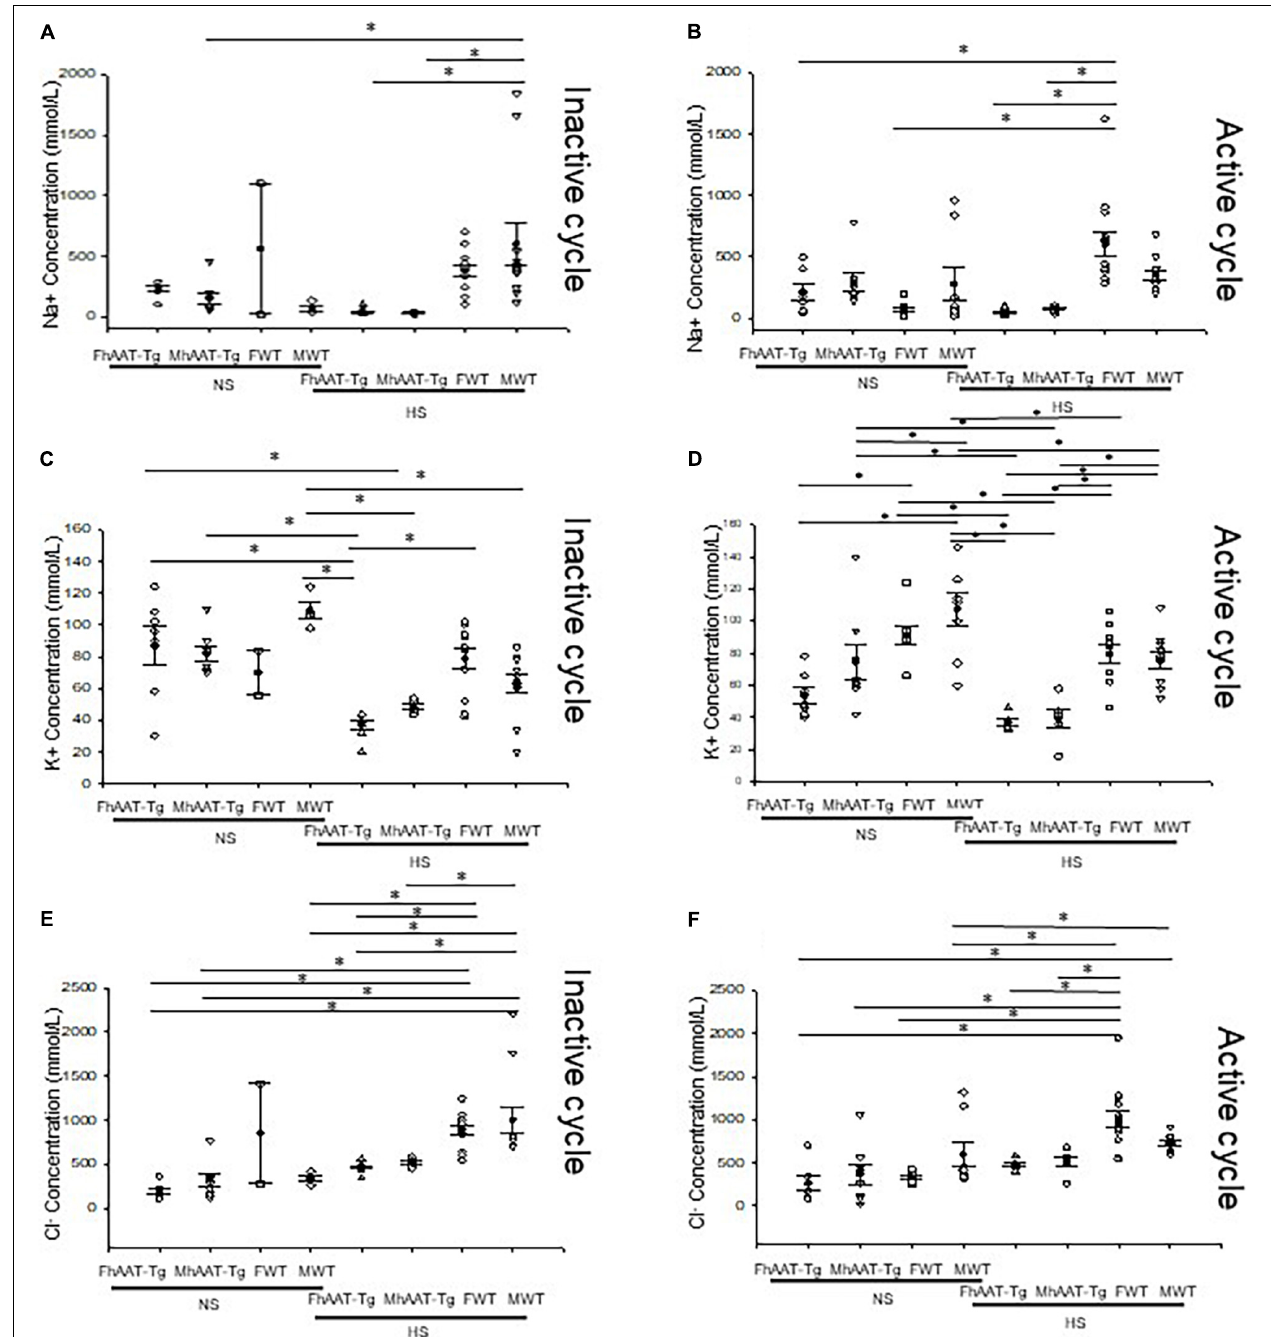
FIGURE 1 | Urinary electrolytes corresponding to the inactive and active cycles of male and female hAAT-Tg and C57B/6 wild-type mice maintained on a normal or high salt diet. (A) Urinary sodium concentrations during the inactive cycle for female and male hAAT-Tg mice and C57B/6 wild-type mice maintained on a normal salt (NS) or high salt (HS) diet. (B) Urinary sodium concentrations during the active cycle for female and male hAAT-Tg mice and C57B/6 wild-type mice maintained on a normal salt (NS) or high salt (HS) diet. (C) Urinary potassium concentrations during the inactive cycle for female and male hAAT-Tg mice and C57B/6 wild-type mice maintained on a normal salt (NS) or high salt (HS) diet. (D) Urinary potassium concentrations during the active cycle for female and male hAAT-Tg mice and C57B/6 wild-type mice maintained on a normal salt (NS) or high salt (HS) diet. (E) Urinary chloride concentrations during the inactive cycle for female and male hAAT-Tg mice and C57B/6 wild-type mice maintained on a normal salt (NS) or high salt (HS) diet. (F) Urinary chloride concentrations during the active cycle for female and male hAAT-Tg mice and C57B/6 wild-type mice maintained on a normal salt (NS) or high salt (HS) diet. N = 7 hAAT-Tg (4 female and 3 male) and N = 8 C57B/6 (4 female and 4 male) mice. These results were analyzed using a One-Way ANOVA followed by a Holm-Sidak comparison. We used a significance level of * p < 0.05.